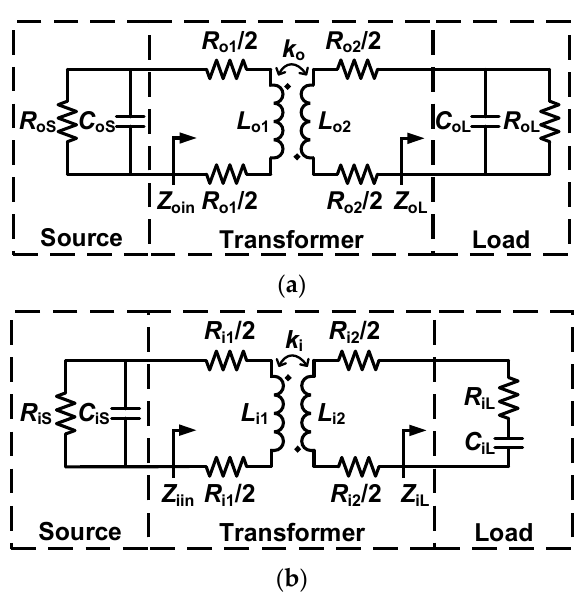
Figure 3. TMN circuit model for ( a ) output matching, ( b ) inter-stage